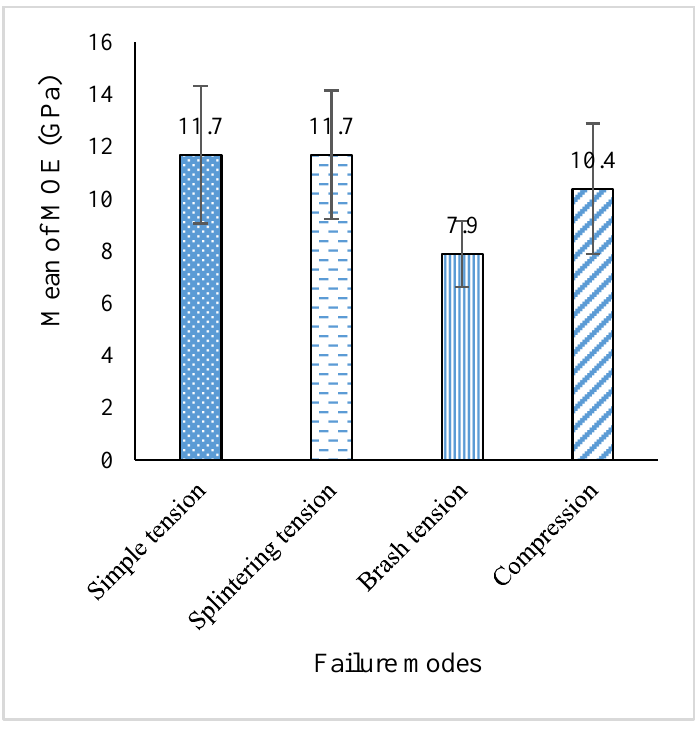
Figure 6. Average modulus of elasticity (MOE) of Eucalyptus urograndis wood corresponding to types of failure.